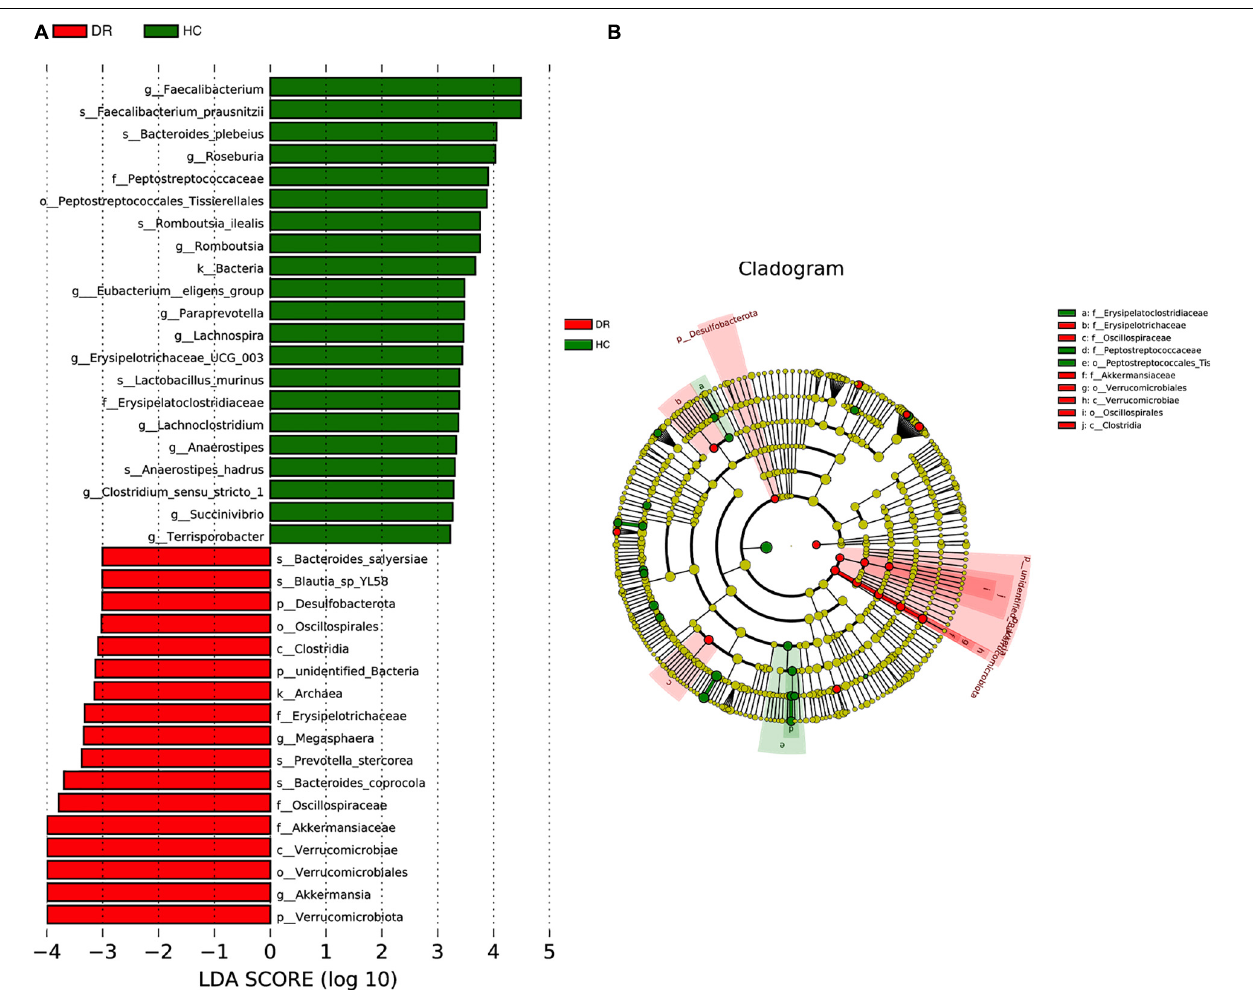
FIGURE 2 | (A) Taxa difference between DR patients and healthy controls. LefSe (LDA > 2logs) was used to detect major differences of bacterial taxa between DR patients and normal individuals. 21 bacterial taxa were enriched in healthy controls (green bars) and 17 were enriched in DR patients (red bars). X -axis shows the log LDA scores. (B) The cladograms of six different taxonomic levels (from kingdom to genus) were constructed. Red circles and shadings show the significantly enriched bacterial taxa were obtained in DR patients. Green circles and shadings show the significantly enriched bacterial taxa obtained in healthy